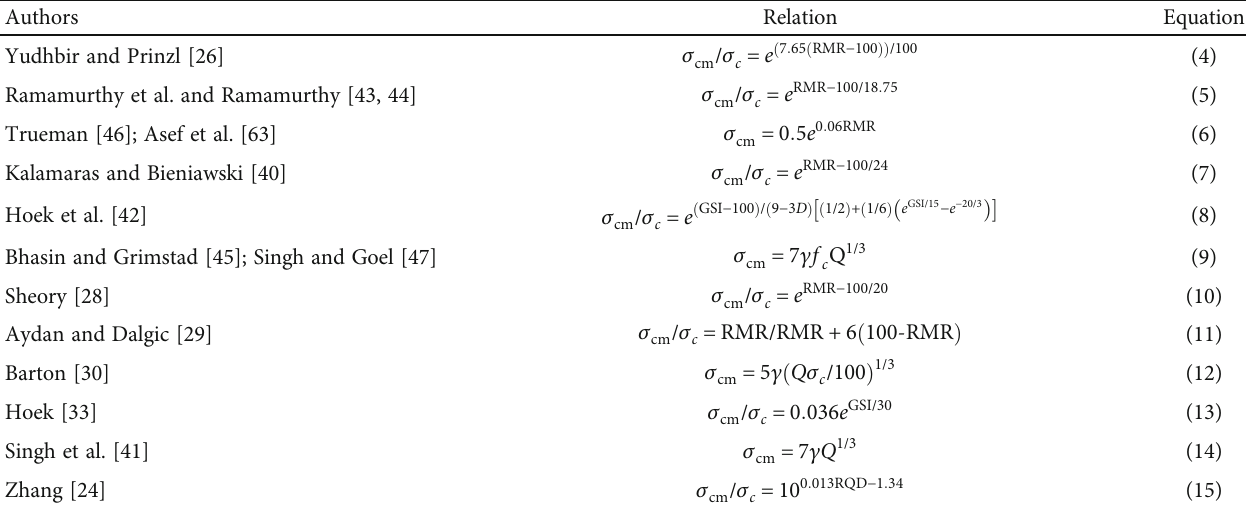
Table 3: Empirical relations from the classi fi cation systems of RQD, RMR, Q, and GSI for determining uncon fi ned compressive strength.